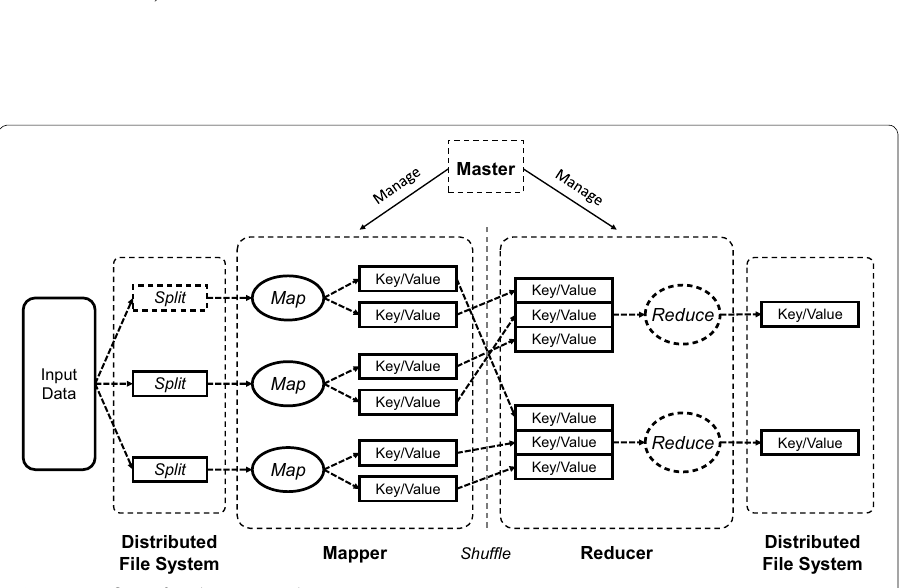
Fig. 1 Data flow of a job in MapReduce